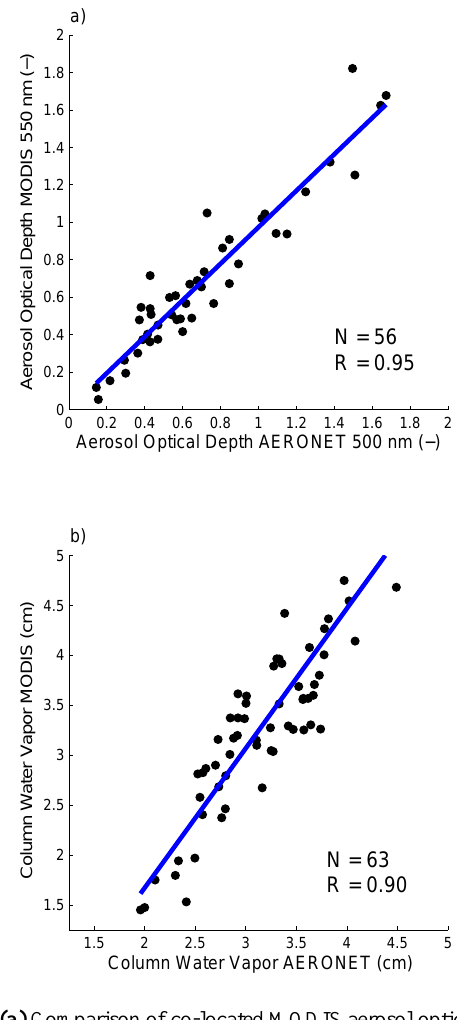
Fig. 2. (a) Comparison of co-located MODIS aerosol optical depth retrievals with Aerosol Robotic Network (AERONET) measure- ments at Abracos Hill (62.358 ◦ W, 10.760 ◦ S) and Ji Paran´a SE (61.852 ◦ W, 10.934 ◦ S) for days used in the study during the months of August through October, for the years 2004 through 2007. These two sites are located within our 5 ◦ × 5 ◦ study region. (b) Com- parison of co-located Level 2 MODIS column water vapor re- trievals with AERONET measurements for the same time period as in (a) . The number of points ( N ) in each plot and correla- tion coefficients ( R ) between MODIS and AERONET data are also included. For each point, MODIS retrievals centered within 15- km of the AERONET station are averaged and compared with 1- h temporally-averaged AERONET data ( ± 30min from the mean MODIS retrieval